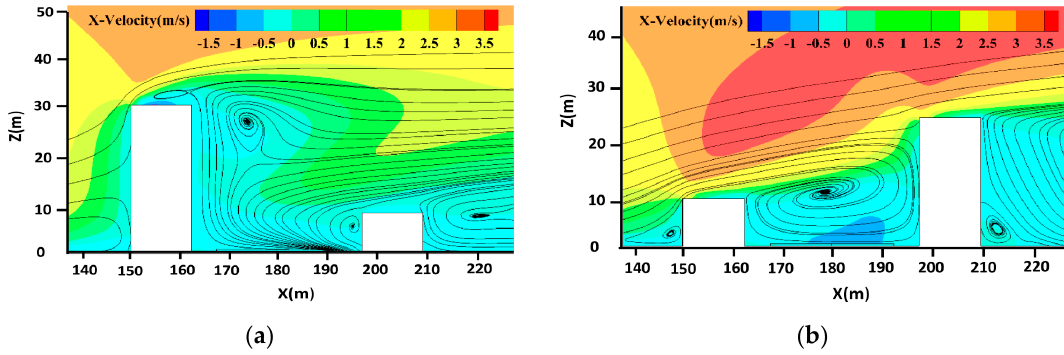
Figure 9. Schematic diagram of the streamline at a wind speed of 3 m/s: ( a ) Y = 210 m section; ( b ) Y = 270 m section.